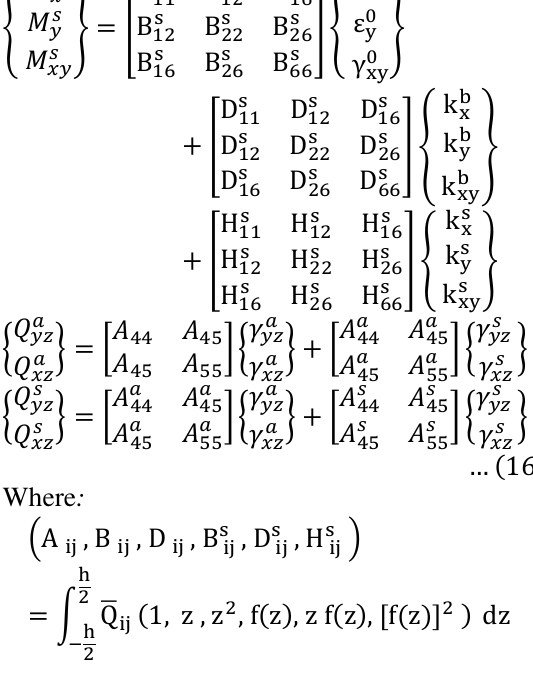
Fig. 2. Boundary condition for simply supported plate.